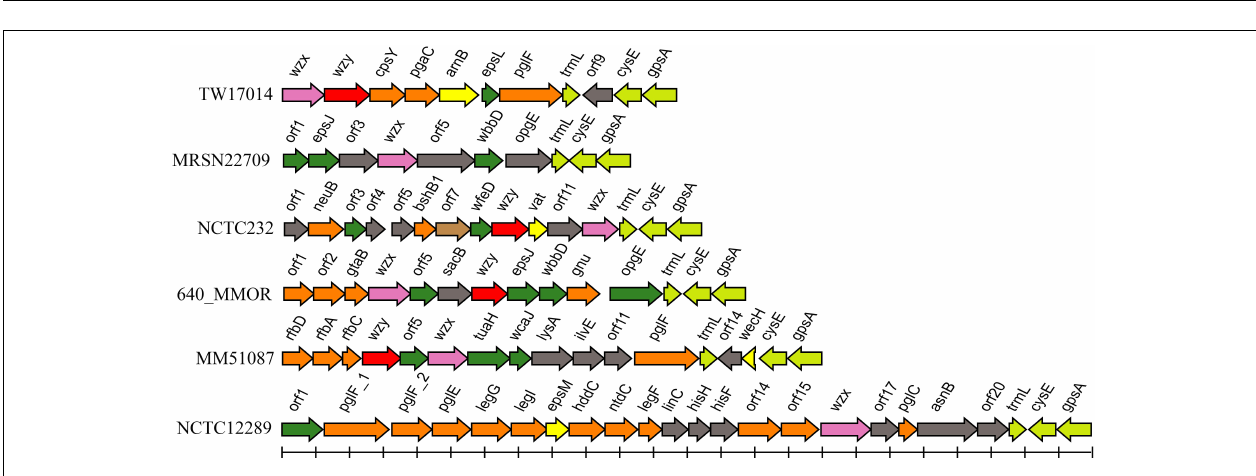
FIGURE 3 | Schematic diagram of the six temporary O-AGCs extracted from M. morganii genomes from GenBank. For the gene key, see Figure 1